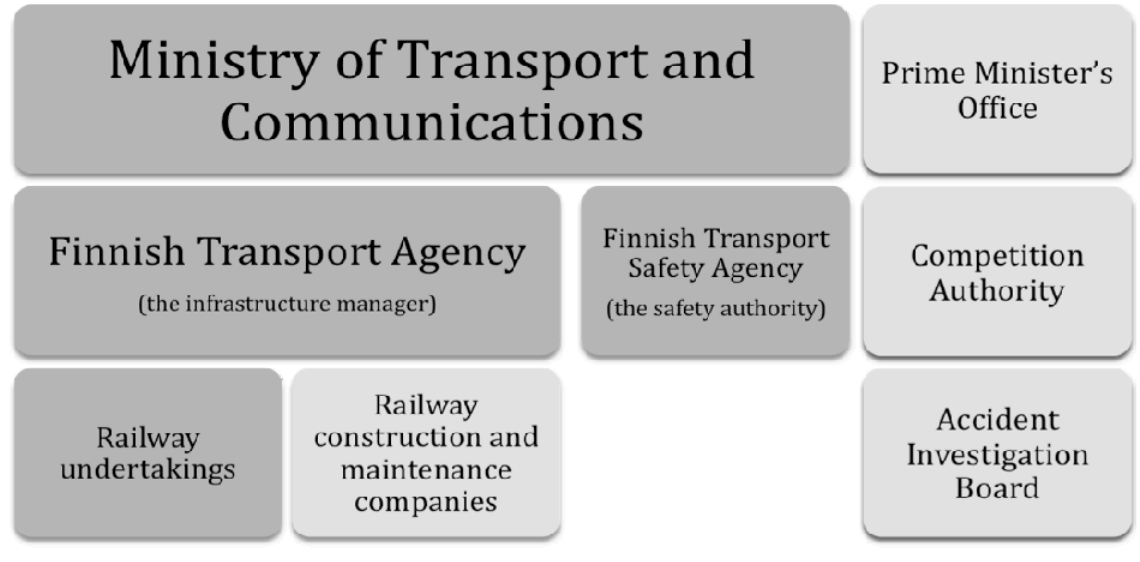
Figure 4. The railway sector structure of Finland